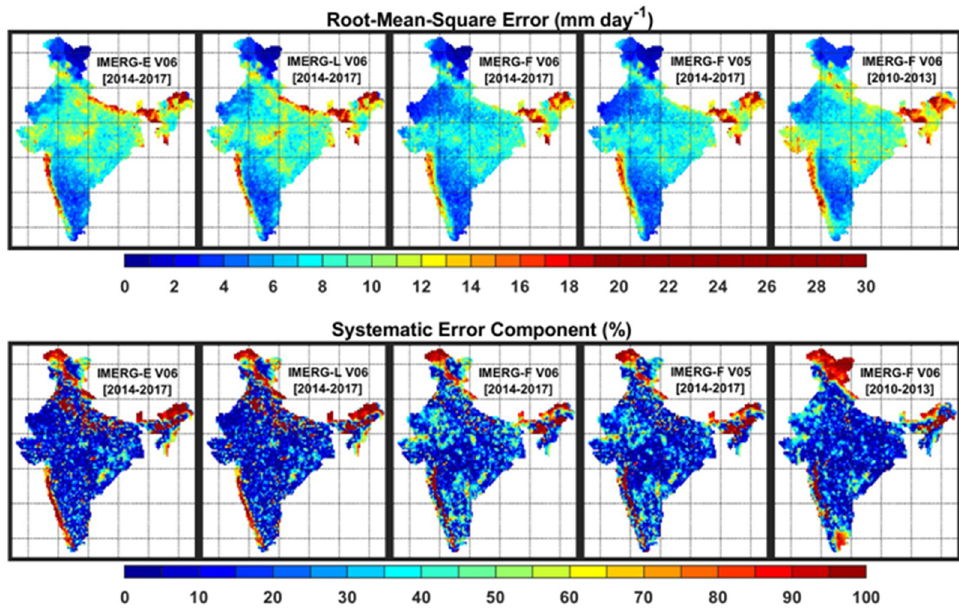
Figure 6. Spatial distributions of root mean square error (mm day − 1 ) and contribution of systematic error component (%) to the total error in IMERG estimates as compared to the rain-gauge-based data over India for the GPM (2014–2017) and pre-GPM (2010–2013) periods.